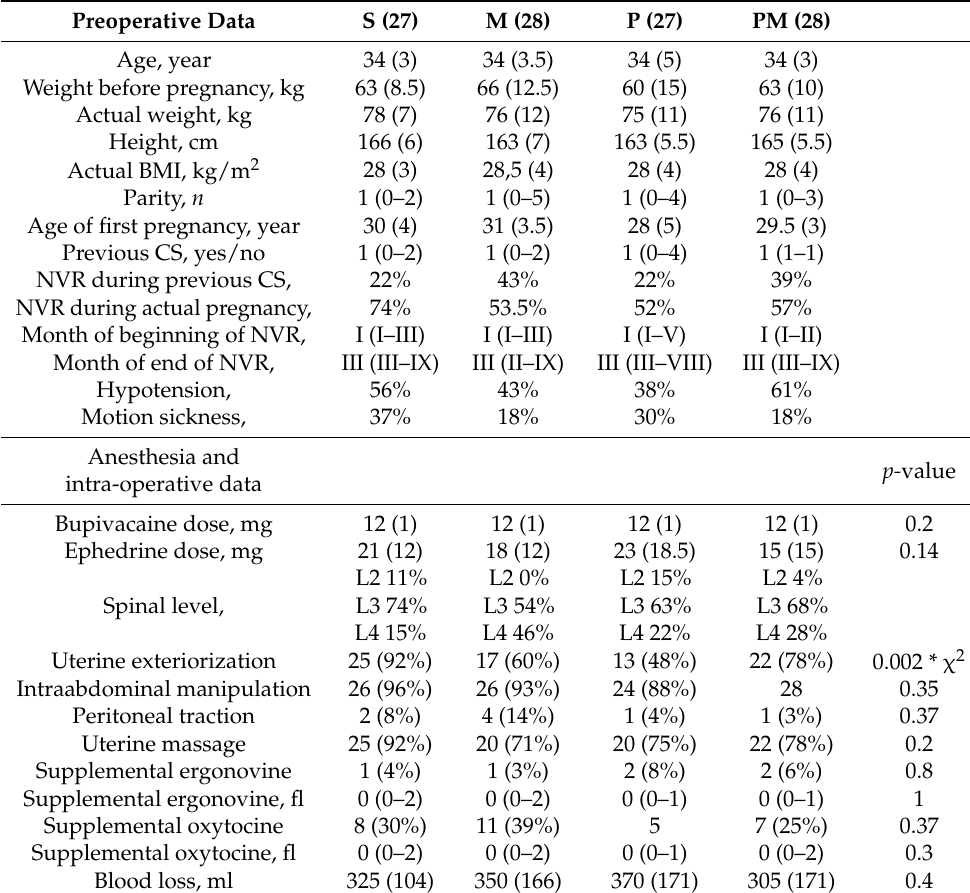
Table 2. Characteristics of women before and during